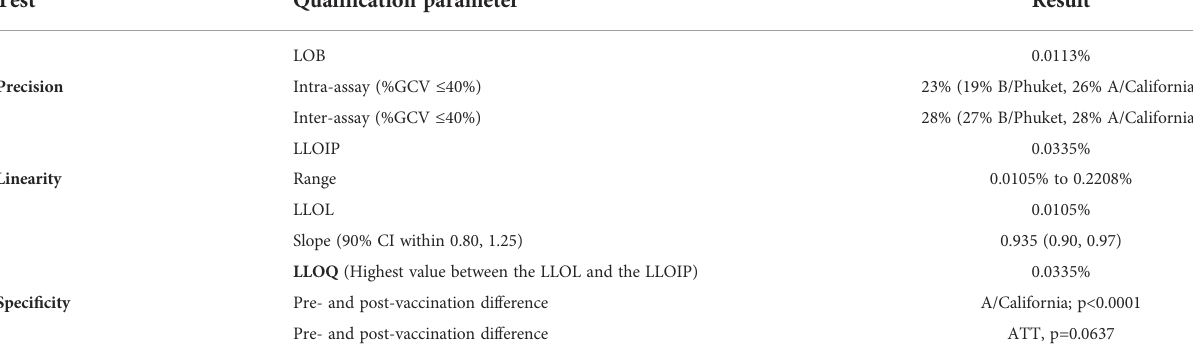
TABLE 3 Summary table for quali fi cation assay results.